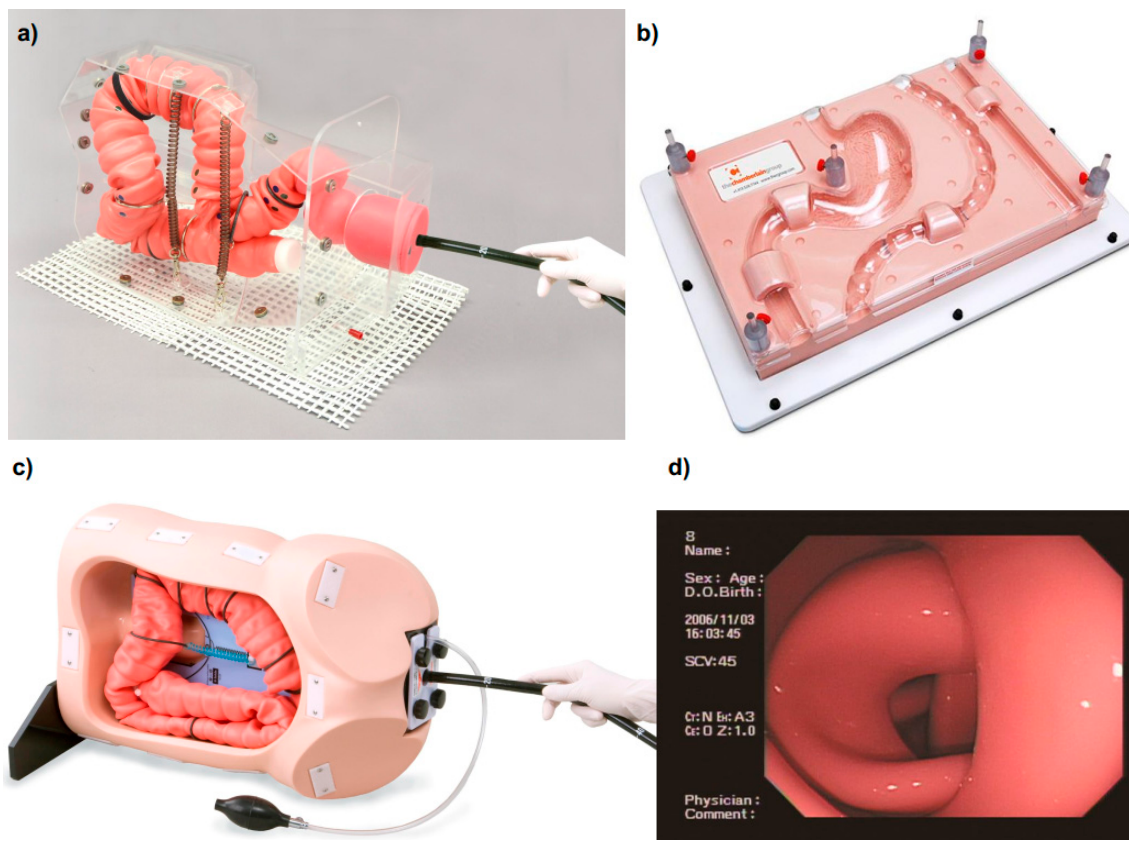
Figure 4. ( a ) Mechanical simulators: a) MW24 NKS Colonoscope Training Simulator from Kyoto Kagaku Co. (Image supplied by Kyoto Kagaku Co.); ( b ) EMS trainer from Chamberlain Group, LLC (Image supplied by Chamberlain Group, LLC, copyright 2021); ( c ) M40 Colonoscope Training Simulator from Kyoto Kagaku Co. (Image supplied by Kyoto Kagaku Co.); ( d ) Internal endoscopic view of M40 Colonoscope Training Simulator from Kyoto Kagaku Co. (Image supplied by Kyoto Kagaku Co.).